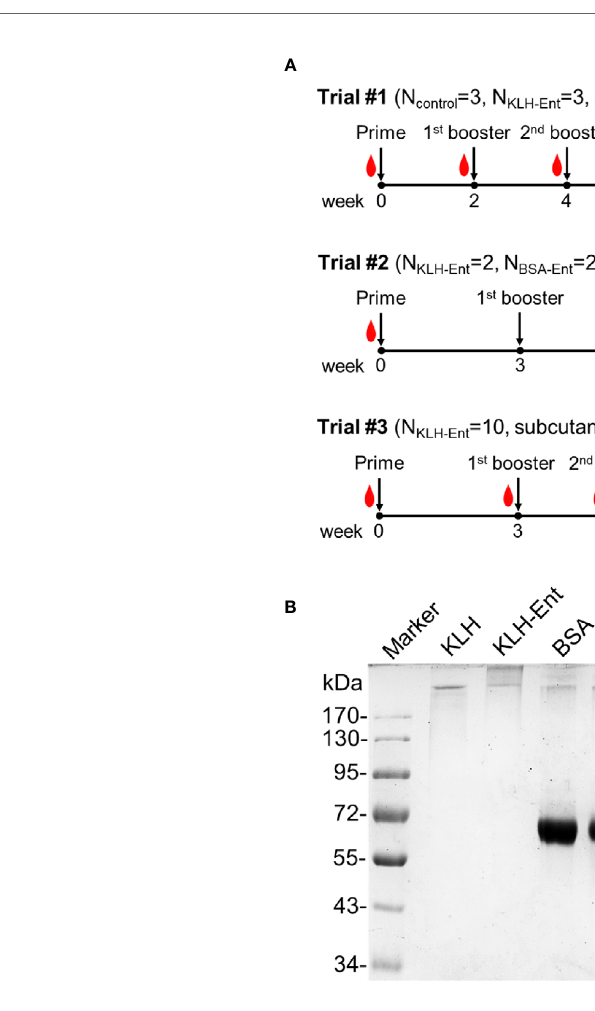
FIGURE 1 | Experimental design for evaluating immunogenicity of the new Ent conjugate vaccines in chickens for production of Ent-speci fi c egg yolk antibodies. (A) Diagram of three immunization trials. The prime and booster immunizations are indicated by downwards arrows while blood sampling was denoted as blood drop. The conjugate vaccines, number of animals in each group and the administration routes are described within the parentheses after each speci fi c trial number. Eggs were collected throughout the trials. (B) SDS-PAGE analysis of three Ent conjugates. Different carrier proteins ( i.e. , KLH, BSA, and CmeC) and corresponding conjugates are indicated above image. The far left lane is the EZ-Run ™ prestained Rec protein ladder (Fisher Scienti fi c) with molecular weight (kDa)